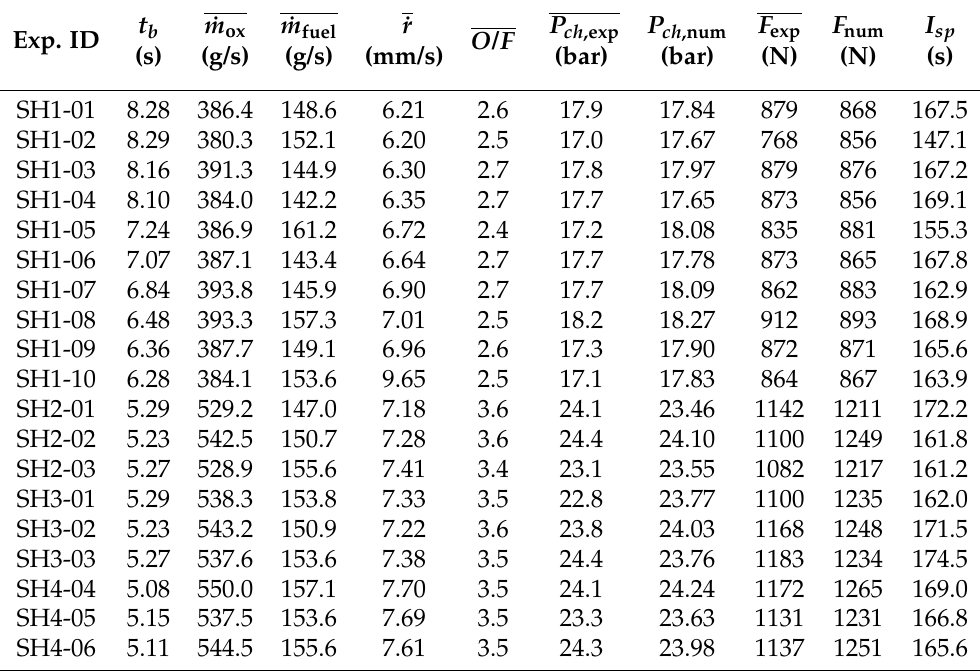
Table 6. Summary of experimental results with 4 different showerhead (SH) injectors. The corre- sponding numerical results are listed as